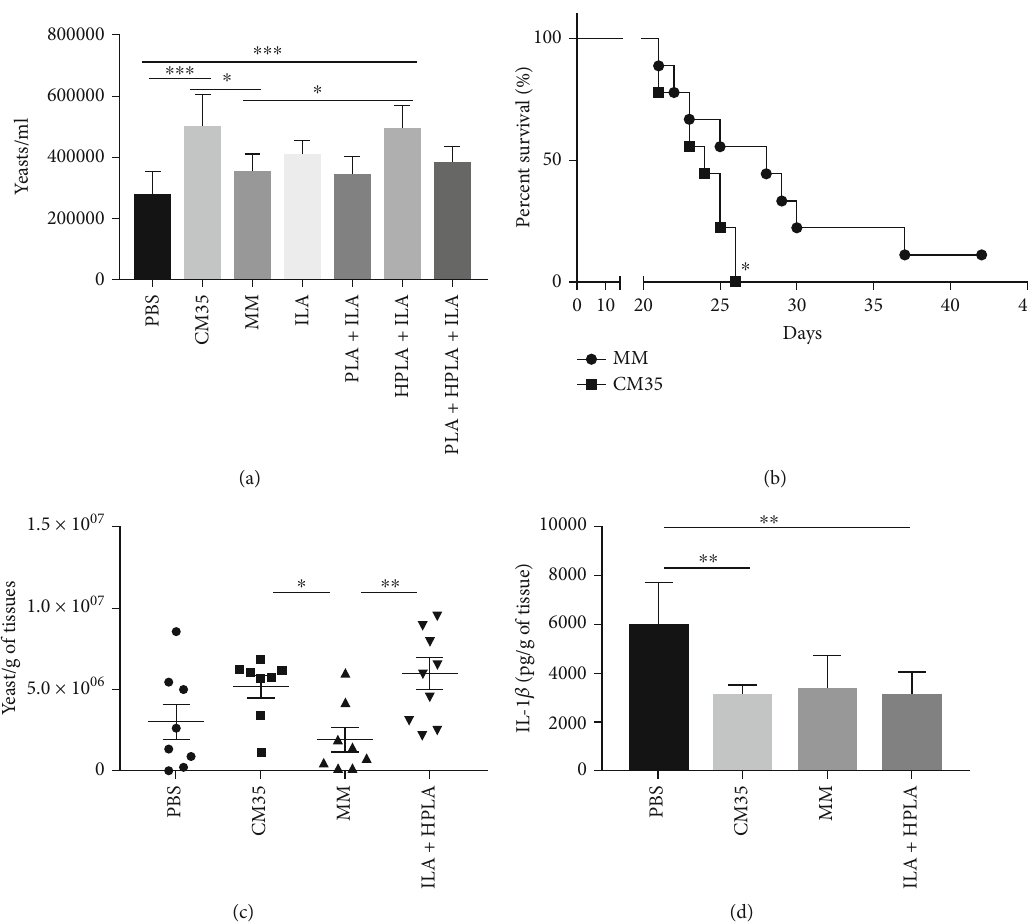
Figure 7: ILA and HPLA increased fungal survival in Acanthamoeba castellanii and mice experimentally infected. Intracellular growth (CFU of 3 h vs. 24 h postinfection) inside A. castellanii was measured by CFU after treatment with 1 kDa CM35, MM, and ILA associated or not with PLA and HPLA. (b) The survival curve of C57Bl/6 infected with 1 × 10 4 H99 strain treated with 1 kDa CM35 or MM during each 5 days intranasally. (c) The lung fungal burden from C57Bl/e infected with 1 × 10 4 H99 strain treated with 1 kDa CM35, MM, or ILA+HPLA each 5 days intranasal repeated after 15 days postinfection. (d) IL-1 β release in lung tissue after 15 days postinfection from C57Bl/e infected with 1 × 10 4 H99 strain treated with 1 kDa CM35, MM, or ILA+HPLA each 5 days intranasal repeated. 1kDa CM35=conditioned media from C. neoformans B3501; MM=minimal media; PLA=DL-3-Phenyllactic acid; HPLA =DL-p- Hydroxyphenyllactic acid; ILA =DL-Indole-3-lactic acid. Statistical analysis was made utilizing one-way ANOVA, where ns: not signi fi cant; ∗ P ≤ 0 : 033 ; ∗∗ P ≤ 0 : 002 ; ∗∗∗ P ≤ 0 : 001 . Comparisons were made with the PBS group (a, b). Comparisons were made with the (c) MM or (d) PBS